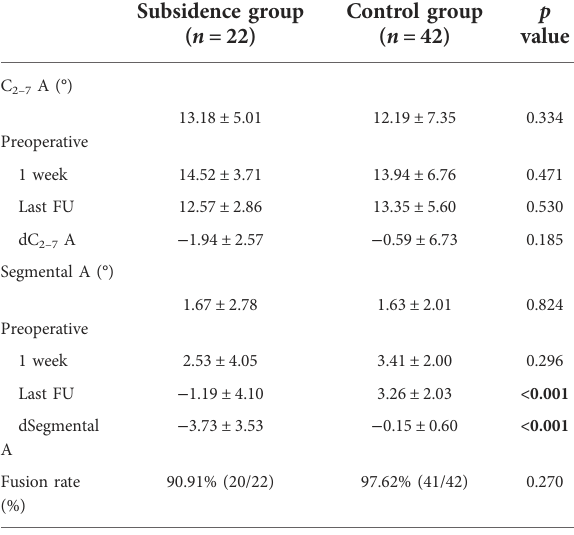
TABLE 4 Comparison of the global and segmental cervical curvature between the groups.